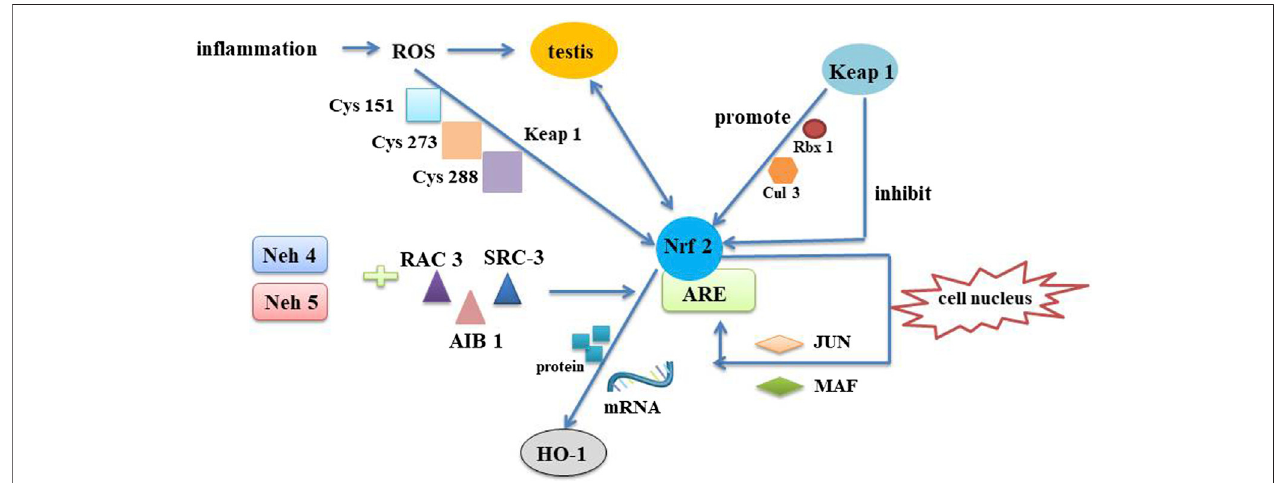
FIGURE 8 | Mechanism of Nrf2/ARE pathway. The Nrf2/ARE pathway is an intrinsic mechanism of resistance to oxidative stress. In the pathological in fl ammatory process, immune cells are fi rst waked. These cells are then recruited to the injury site and produce ROSto destroy the testis. Neh4 and Neh5, a part of functional domains of Nrf2, mutual effect with nuclear cofactor RAC3/AIB1/SRC-3 can result in expression intensity of Nrf2-targeted ARE gene. When oxidative stress occurs, ROS respond to cysteines on Keap1 to induce a conformational change in the release of Nrf2, thereby eliminating its degradation. As a consequence, Keap1-assisted Cullin3/Rbx1-dependent polyubiquitination of Nrf2 is interdicted, and Nrf2 is released and quickly relocated into the nucleus. Once entering the nucleus, Nrf2 is engaged in heterodimerization with minor MAF or JUN proteins and their complexes combine with the ARE. HO-1 is the derivable isomer and limiting velocity enzymes. Nrf2 upregulats mRNA and protein expression through induction of HO-1 gene. Nrf2, Nuclear factor erythroid 2-related factor 2; Keap1, Kelch-like ECH-associated protein 1; ARE, antioxidant response element; MAF, musculoaponeurotic fi brosarcoma; RAC3, receptor-associated coactivator 3; SRC-3, steroid receptor coactivator-3; Neh5, Nrf2-ECH homology 5; Neh4, Nrf2-ECH homology 4; ROS, reactive oxygen species; Rbx1, RING-box protein 1; HO-1, heme oxygenase-1.